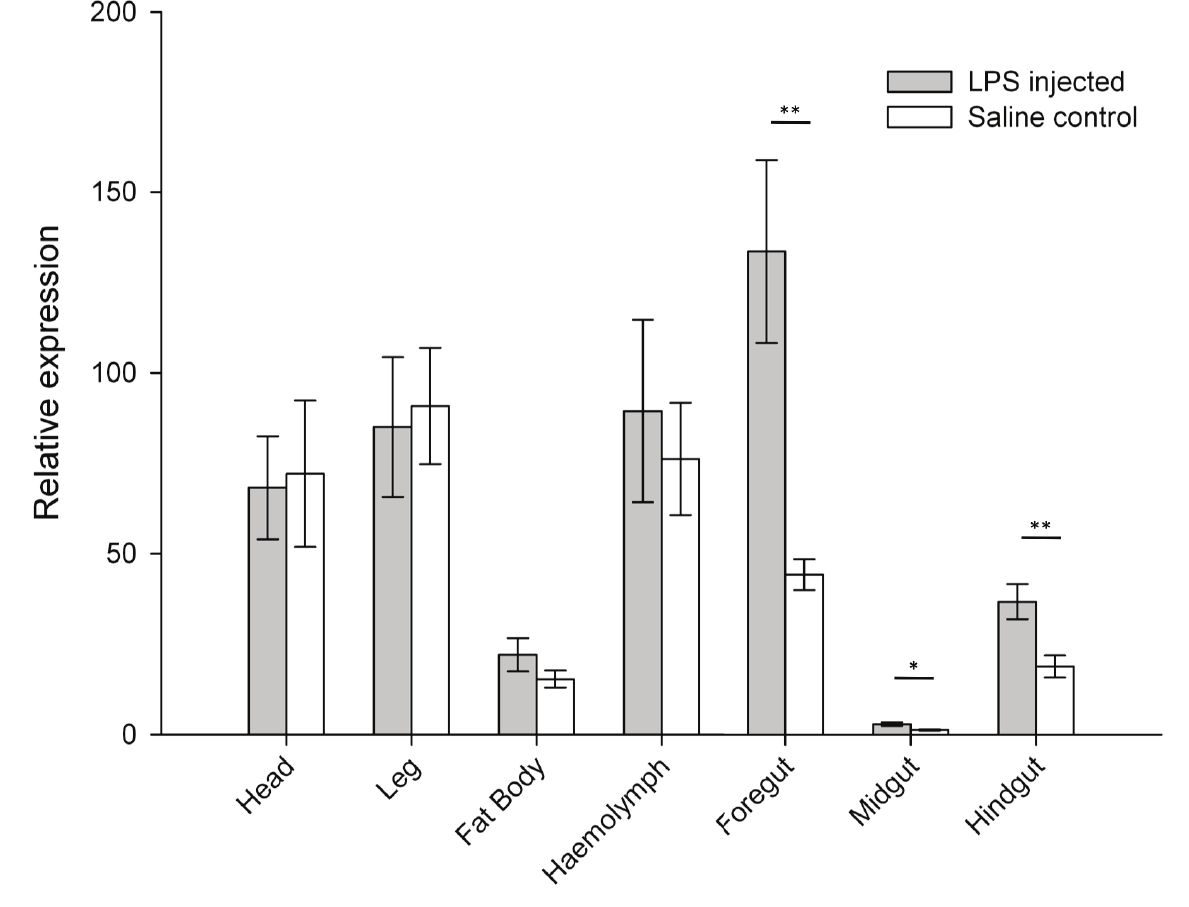
Figure 3. Relative expression levels of the gene coding for Prophenoloxidase (ProPO) across seven tissue types in LPS-injected and saline control Locusta migratoria . Error bars = ± SEM. * p < 0.05, ** p <